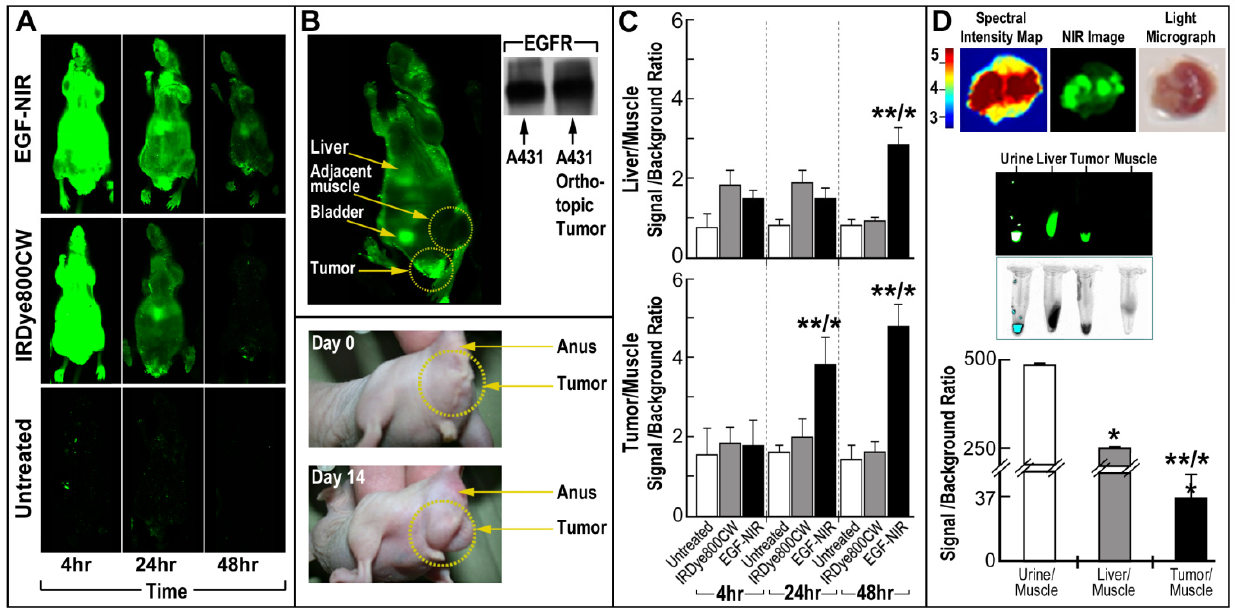
Figure 6. Whole body in vivo and isolated tissue ex vivo NIR bio-imaging of mice with A413 orthotopic tumors. ( A ) Time course of EGF-NIR accumulation in tissues of tumor bearing mice. The mice were injected intravenously with 1 nmol of EGF-NIR or IRDye800CW or left untreated ( n = 3); ( B ) Tissue accumulation of EGF-NIR probes at 48 h; region of interest (ROI) marked with circles; Western blotting of tumor and A431 culture indicate EGFR expression; Right graphs: time course of EGF-NIR SBR in tumor and liver compared to skeletal muscle. Signal intensity at 800 nm was normalized to background fluorescence using an arbitrary tumor circle (ROI) compared to an identical area on the flank (adjacent muscle). Significance: * p < 0.05 compared to untreated; ** p < 0.05 compared to mice injected with IRDye800CW; ( C ) EGF-NIR SBR in isolated tissue from the tumor-bearing mice 48 h after injection; ( D ) Upper three photos: NIR image, light micrograph and spectral intensity map of EGFR visualized by EGF-NIR (green and brown represent high levels of EGFR); NIR scanning of tissue samples in tubes, from mice 48 h after EGF-NIR injection. SBR between tissue of interest and skeletal muscle reflecting EGF-NIR distribution; NIR imaging was estimated at the following conditions: resolution: 170–340 microns; pixel area: 0.03 mm 2 ; quality: medium-low; focus offset: 3; channels: 800 nm; intensity: 3; * p < 0.05 compared to muscle; ** p < 0.05 compared to